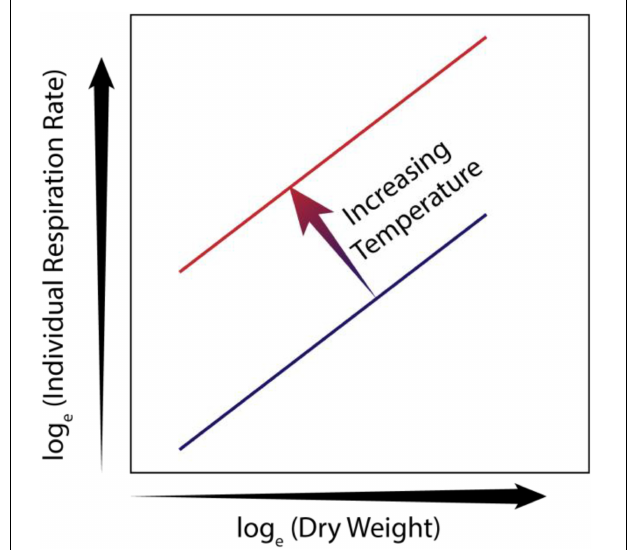
FIGURE 5 | Conceptual figure showing natural log transformed respiration rate (ln R) of a copepod versus copepod dry weight (ln DW), and the effect of temperature on the relationship, based on data from Castellani and Altunbas (2014). Lines represent the relationship between ln R, ln DW for different temperatures. Note the slope remains the same but the overall respiration at a given size increases with